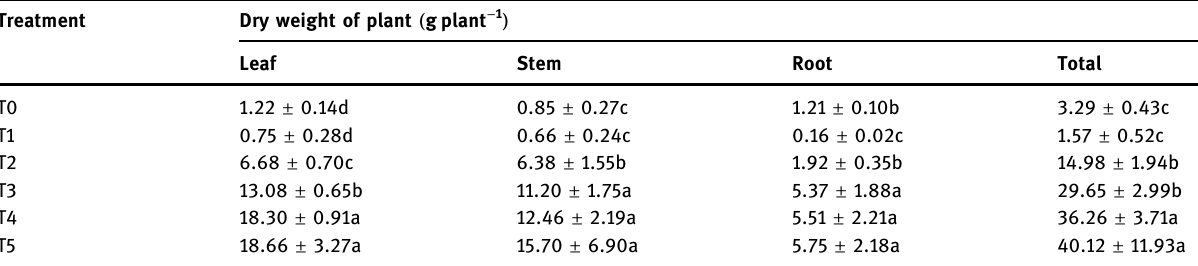
Table 6: E ff ects of amending CIRP with RS compost on dry weight of Zea mays L. F1 hybrid sweet corn 801 variety at 60 DAS of pot experiment